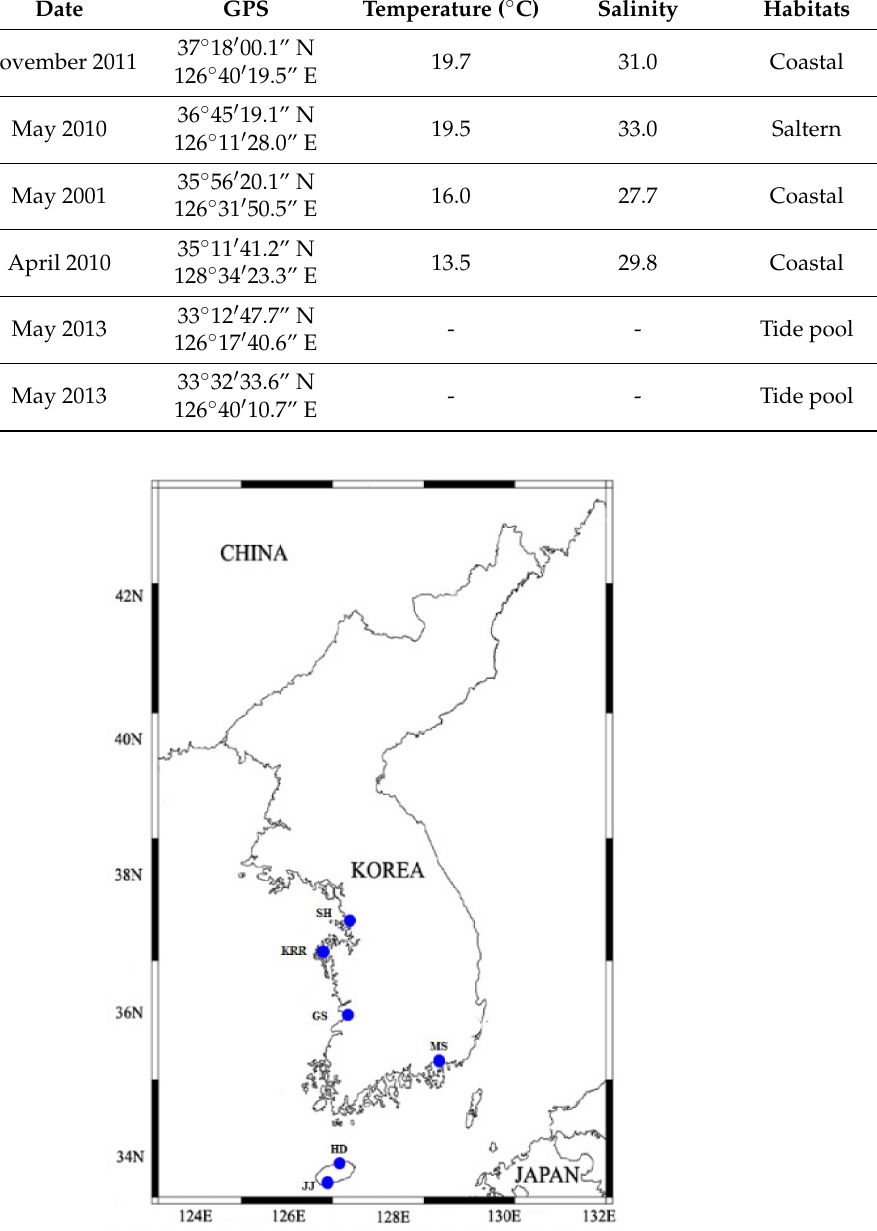
Figure 1. Map of the sampling stations of Oxyrrhis marina (Shiwha [SH], Karorim [KRR], Gunsan [GS], Masan [MS], Korea) and O. maritima (Jeju-Anduck [JJ] and Hamduck [HD], which are located in Jeju Island,